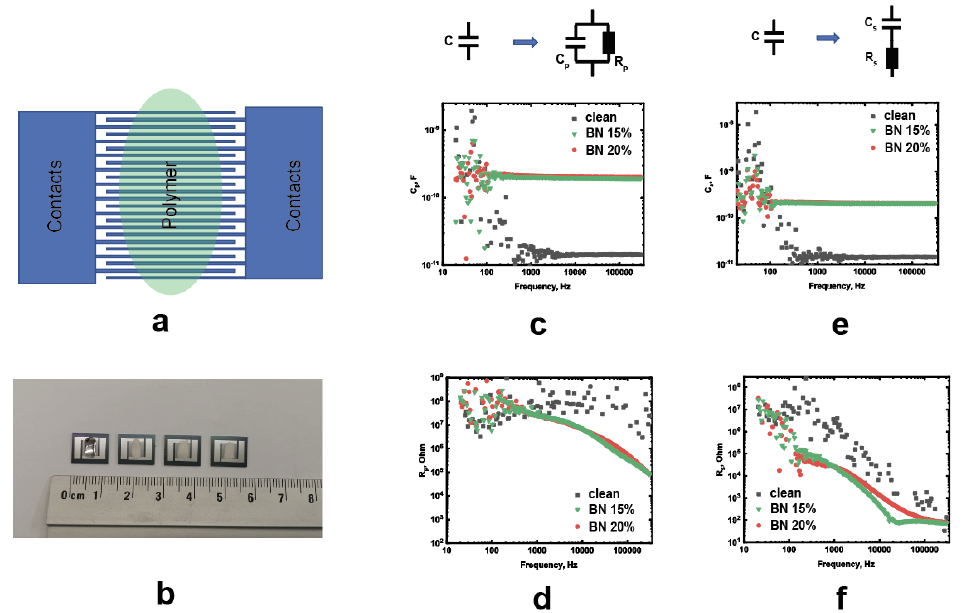
Figure 7. ( a ) Scheme of the coplanar interdigital capacitors with the composite sample; ( b ) photograph of the samples; ( c , d ) frequency-dependent C p and R p for the parallel connection; and ( e , f ) frequency-dependent C p and Rp for the series connection.